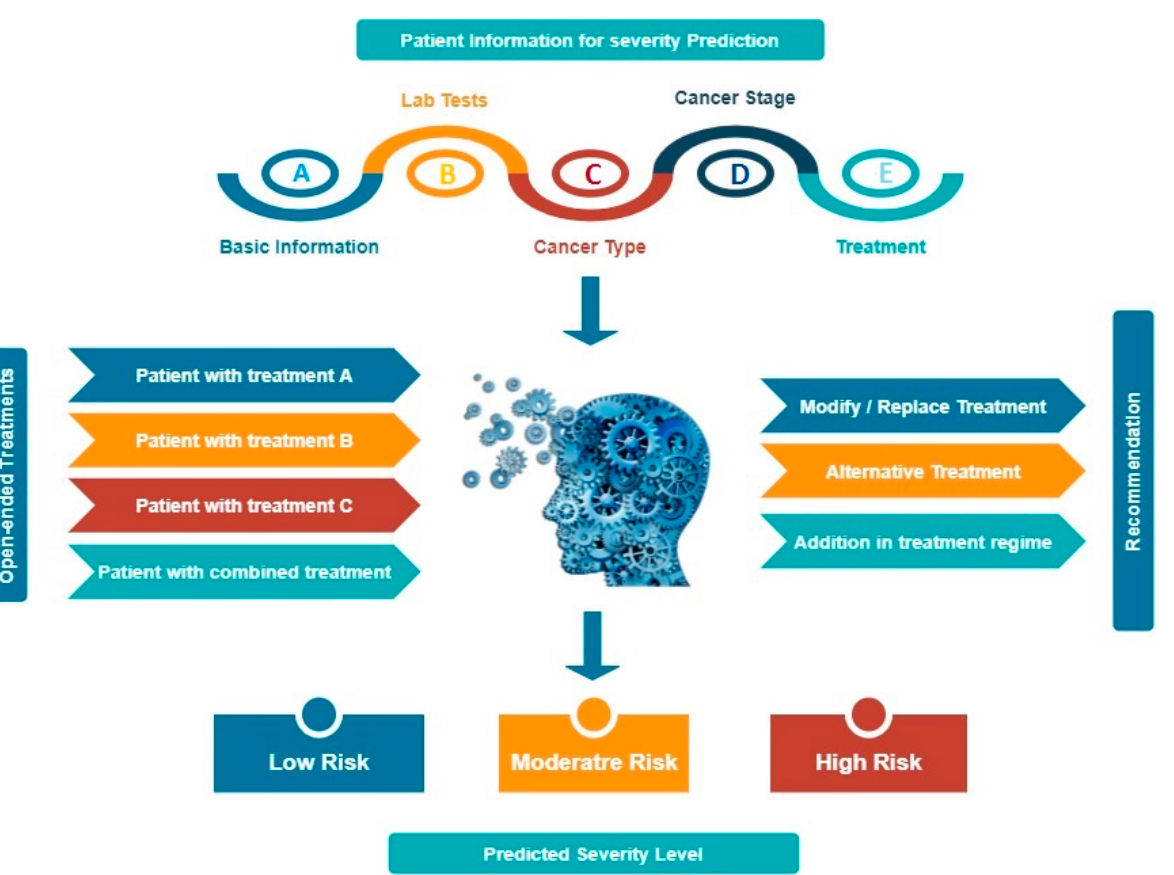
Figure 7. Incorporation of machine learning algorithm for the prediction and analysis On the top and left panel involves the input data whereas on the bottom and right panel involves the output data after the training of machine. The topmost input data involving ( A ) basic information—age, sex, race and common symptoms, ( B ) lab tests—WBCs, lymphocyte, neutrophil, platelet count, C-reactive protein level, lactate dehydrogenase, D-dimer level, IL-6 level and so on, ( C ) cancer type—lung, breast, prostate, gastric, ovarian, leukemia or others, ( D ) cancer stage—I, II, III, IV, ( E ) treatment—radiotherapy, chemotherapy, immunotherapy, surgery or targeted therapy or others. The output data can help in the prediction of the severity level—low, moderate or high. The left input data involves the ongoing treatments of the patients could be radiotherapy, chemotherapy, immunotherapy and the output data could help the oncologists to recommend their patients; whether the treatment needs to be modified, altered or additional changes required.